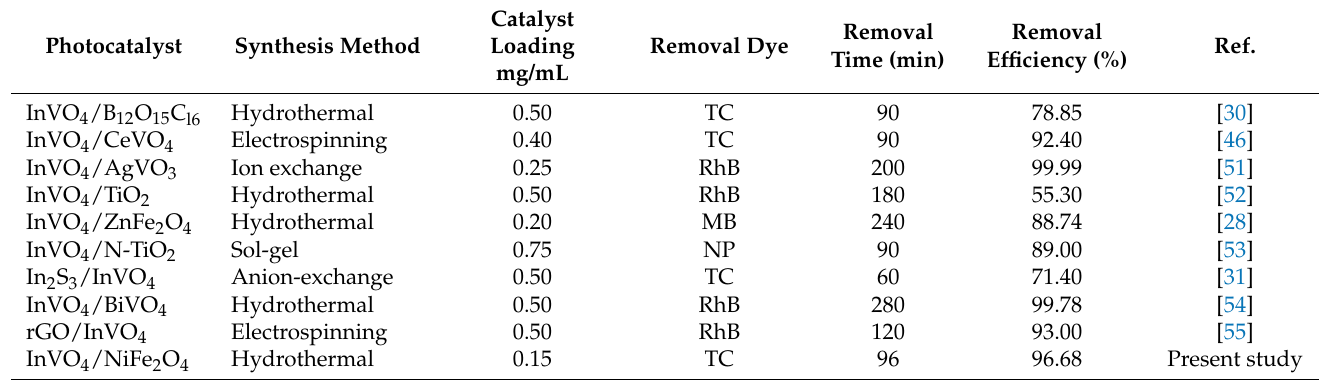
Table 1. A comparison of photocatalytic removal of pollutants under visible light using InVO 4 -based nanocomposites with recent examples from the literature.